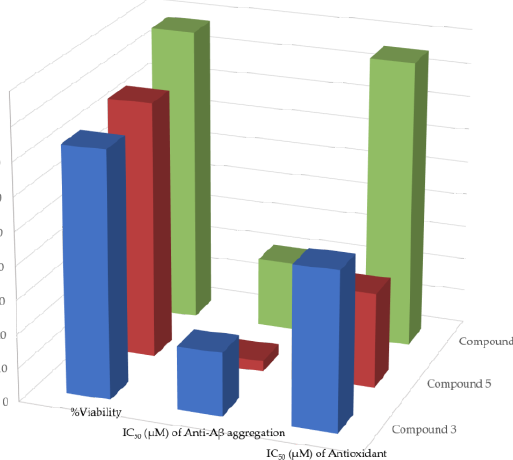
Figure 5. Correlations of %viability of SK-N-SH cells, IC 50 values (µM) of anti-A β aggregation, and IC 50 values (µM) of antioxidants of compounds 3 , 5 , and 8